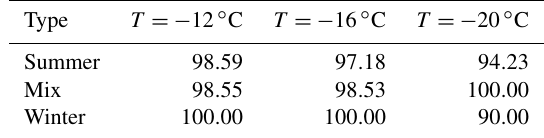
Table 3. Fraction of samples (in %) falling in the range of a factor of 10 above to a factor of 10 below the parameterizations given in Table 2 for T = − 12, − 16 and − 20 ◦ C (for all spectra together with the parameterizations and upper and lower bounds, see Fig.